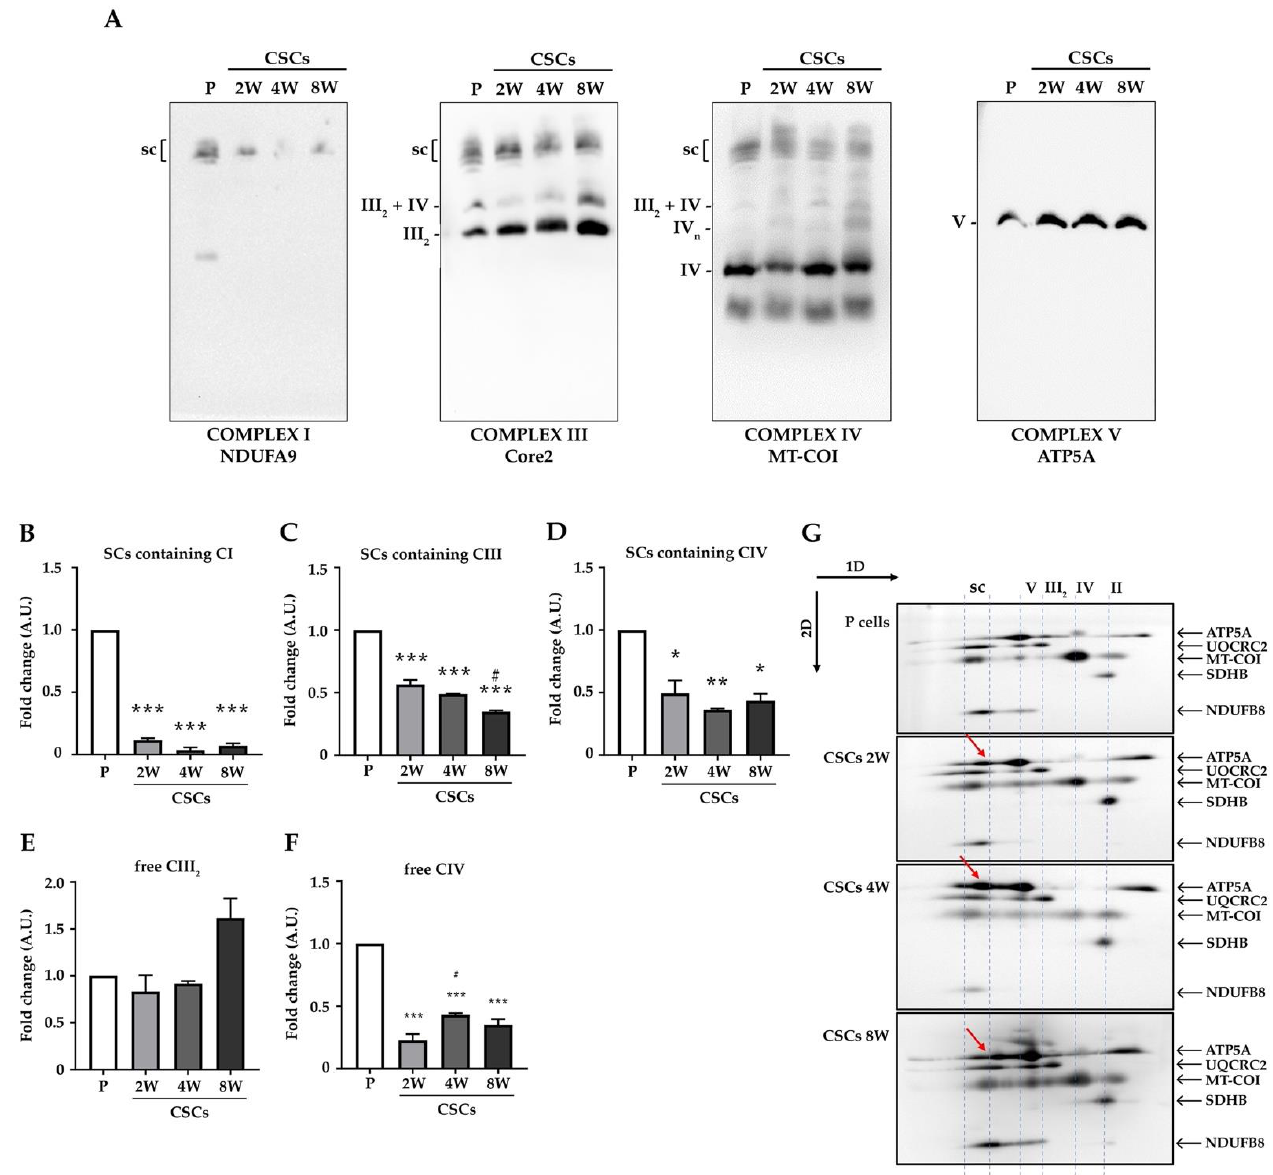
factor 1 (IF1) and densitometric quantification (histogram) of three different biological replicates of IF1 expression. Tubulin is shown as a loading control. ( C ) Right panel, representative immunoblots of three different biological samples of the expression of mitochondrial respiratory proteins from complex I (NDUFA9), complex II (SDHB), complex III (core2), complex IV (MTCO1), and complex V (ATP5A). Ponceau Stain, tubulin, and TOMM20 are shown as loading controls. Left panel, den- sitometric quantification of mitochondrial respiratory proteins normalized to TOMM20. ( D ) The histograms show the enzymatic activity of the complex II, complex IV, and citrate synthase of three different biological replicates by spectrophotometry. The values are reported as fold change relative to P cells. Histogram legends: white: P cells; light gray: CSCs 2 weeks; dark grey: CSCs 4 weeks; black: CSCs 8 weeks. Bars indicate the mean ± SEM of different experiments as indicated. Statistical legends: Parental vs. CSCs = * p < 0.05, ** p < 0.01, *** p < 0.001; 2W CSCs vs. CSCs = # p < 0.05, ## p < 0.01.